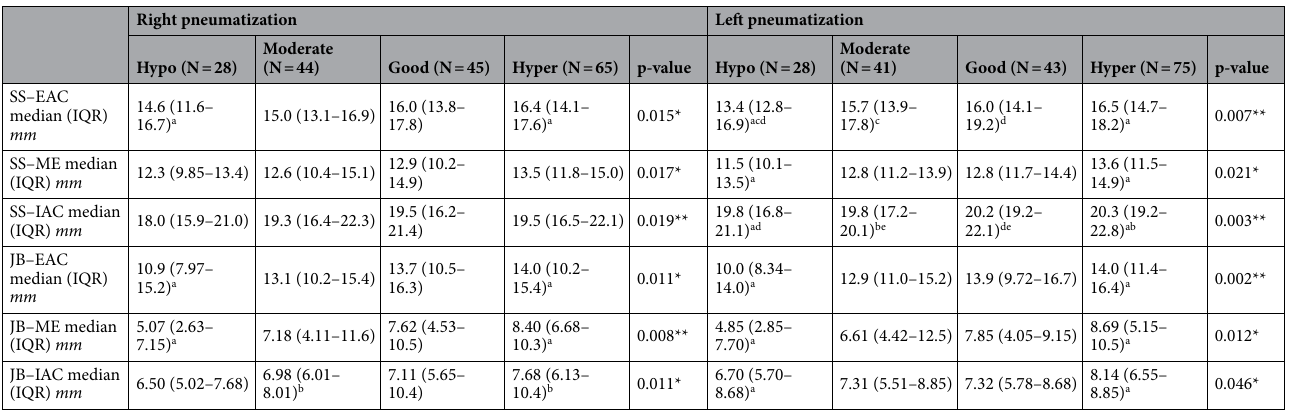
Table 4. Association between pneumatization of temporal bone and distances of the sigmoid sinus and jugular bulb to selected ear regions (external acoustic canal, middle-ear & internal acoustic canal). mm millimeters, IQR Interquartile range, SS sigmoid sinus, JB jugular bulb, EAC internal acoustic canal, ME middle-ear, IAC internal acoustic canal. Significant association at *p < 0.05, **p < 0.01 with significant difference, a, b, c, d, e, (Kruskal–Wallis test followed by Wilcoxon Signed Rank test). a hypo vs. hyper. b good vs. hypo. c hypo vs. moderate. d hypo vs. good. e moderate vs. good.